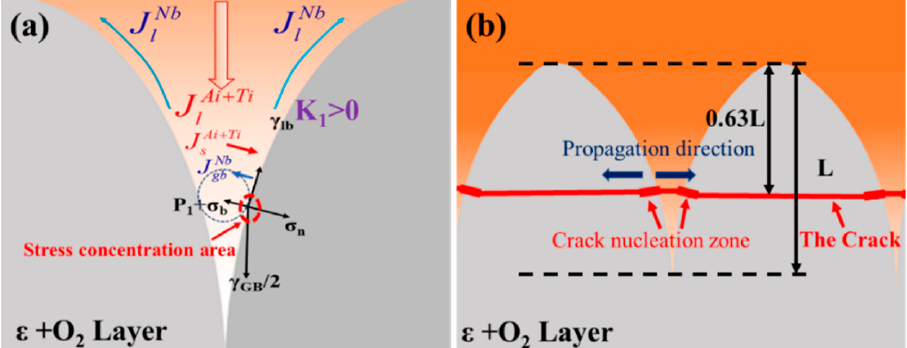
Figure 8. ( a ) Schematic illustration of the related mechanical interactions coupled with the mass flux, ( b ) sketch of crack nucleation and propagation.